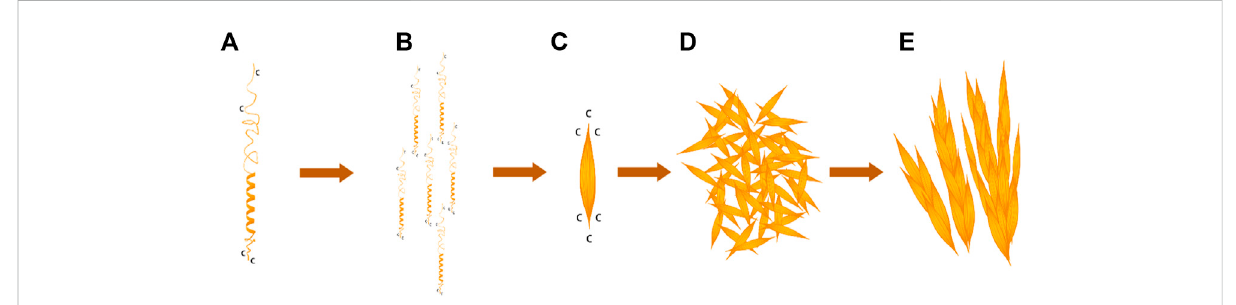
FIGURE 7 BalCP20-P3 self-assembly mechanism. (A) Spiral model of BalCP20-P3. (B) Monomer arrangement model of BalCP20-P3. (C) Spindle of BalCP20-P3. (D) Self-assembly model of BalCP20-P3 under TEM. (E) Model of the wheat spike structure of